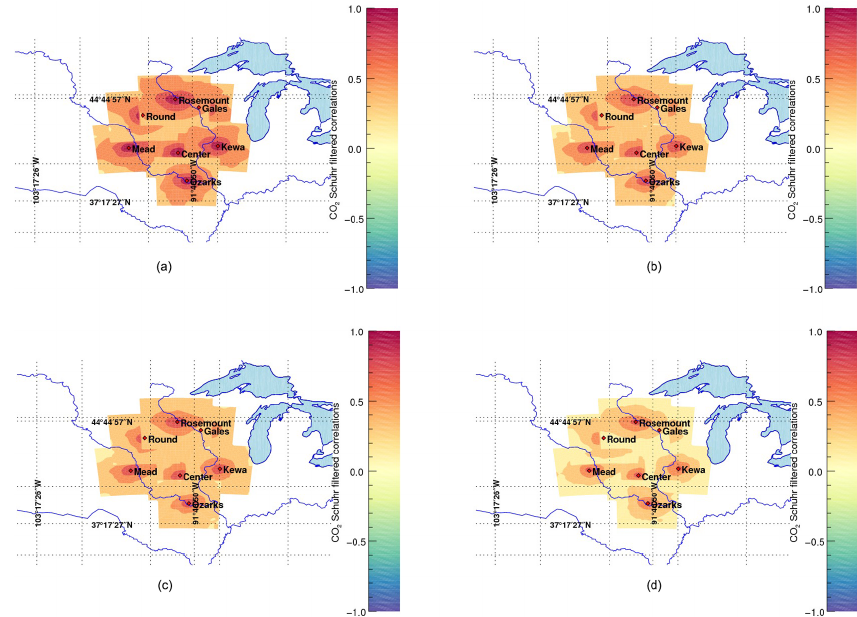
Figure 9. Filtered correlations (using Schur product only) of CO 2 in situ mole fractions (about 100ma.g.l.) (in ppm 2 ) (about 100ma.g.l.) (in ppm 2 ) using 25 members (a) , 10 members (b) , 8 members (c) and 5 members (d) .